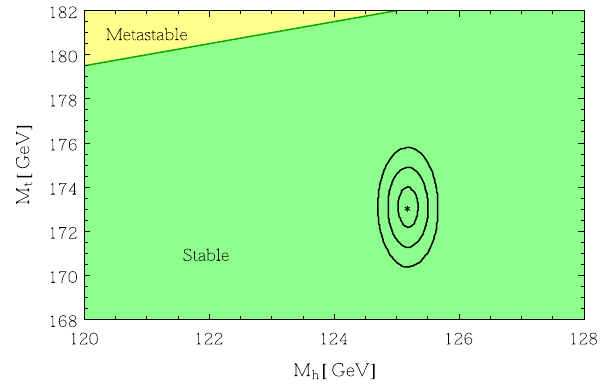
Fig. 15 Higgs mass M h vs top quark mass M t plot in GeV for one generation of (cid:2) R 2 and S 3 . The green and yellow colours represent stable and metastable regions. The black circles are 1 σ , 2 σ and 3 σ contours, with the current experimental values of Higgs mass and top quark mass denoted by dots at the